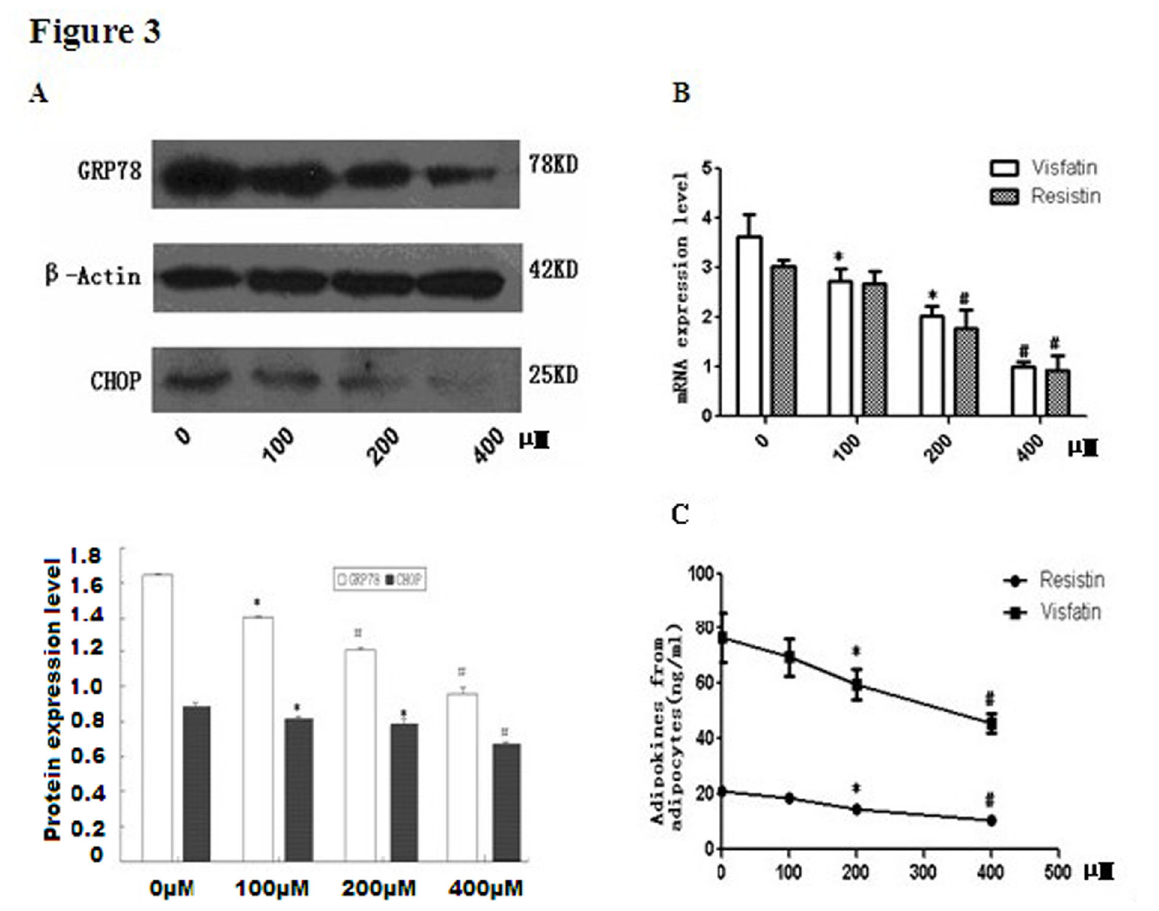
Figure 3. Chemical Chaperone Treatment Protects cells from secretion dysfunction. Differentiated 3T3-L1 adipocytes were incubated in the medium with ox-LDL(50µg/ml) （Sandoz58035 and different concentration of TUDCA (0-400µM) for 48hrs. GRP78 and CHOP expression was determined by Western Blot and β-actin was used as the housekeeping gene for normalization(A). Lane 1: control; lane 2: TUDCA at 100µM; lane 3: TUDCA at 200µM; lane 4: TUDCA at 400µM. The mRNA expressions of resistin and visfatin were evaluated by real-time PCR (B).Resistin and visfatin release from 3T3-L1 adipocytes into supernatant medium were analyzed by ELISA (C). * P<0.05, as compared with control; # P<0.01, as compared with